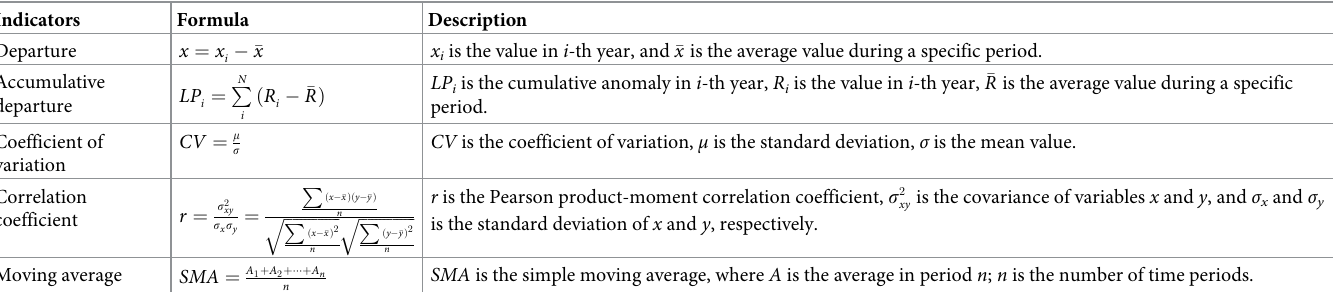
Table 2. Description of the statistical indicators used in this study.